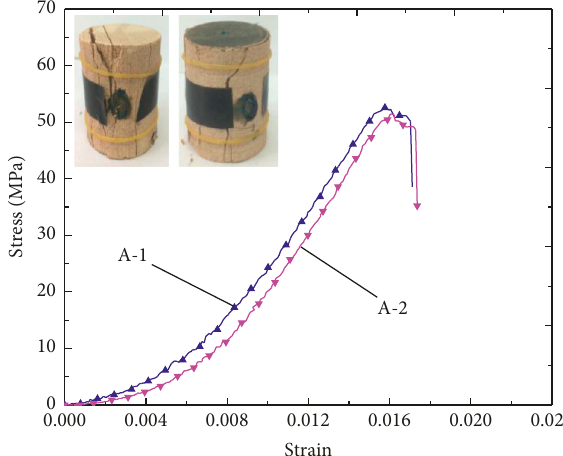
Figure 1: Mechanical properties of the sandstone.